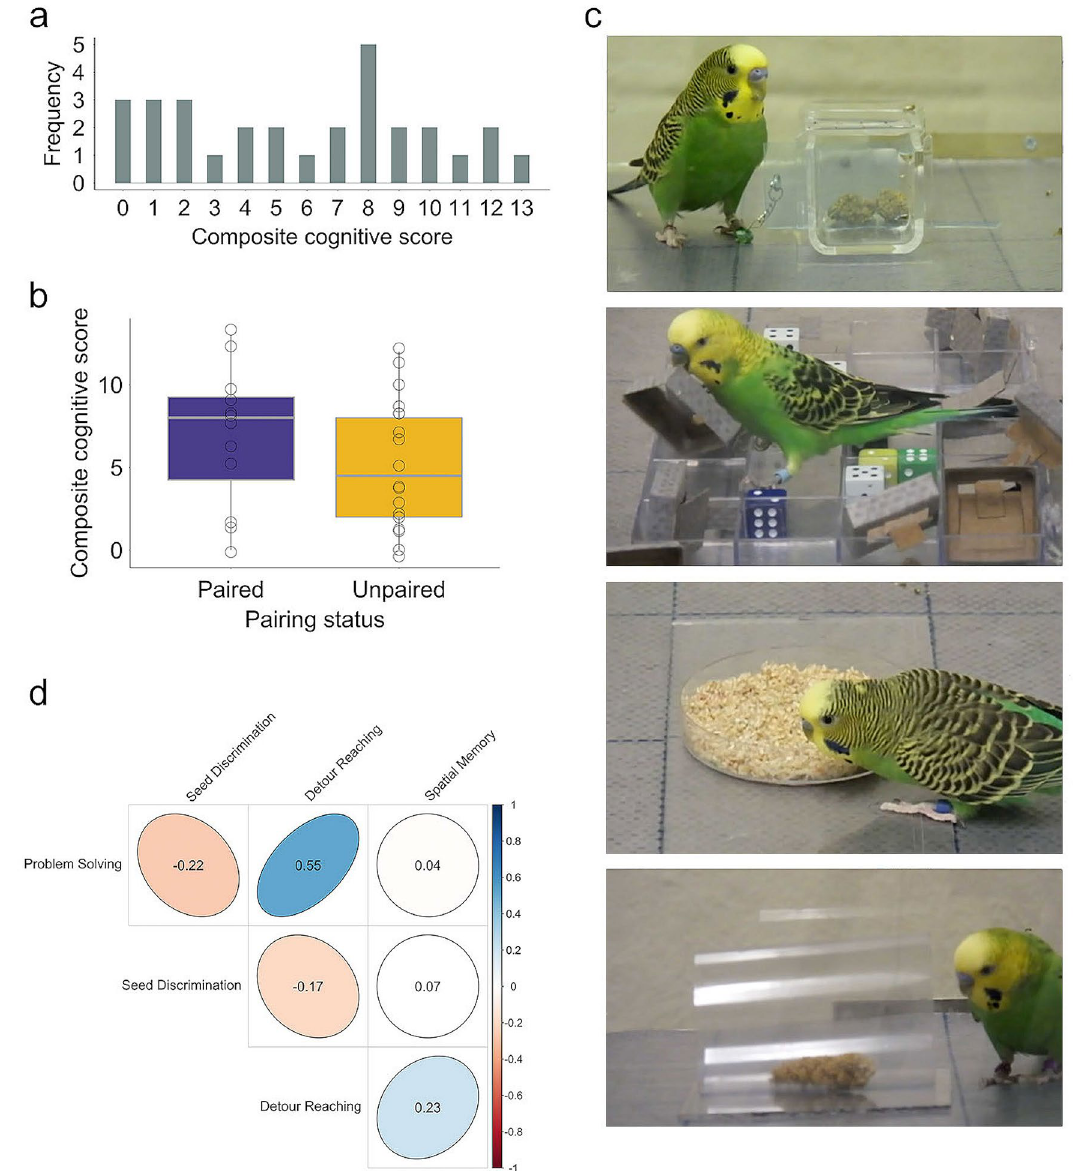
Figure 1. Females do not pair with social mates based on cognitive performance. ( a ) Distribution of the composite cognitive score of budgerigar males ( N = 30). ( b ) Composite cognitive scores did not differ between unpaired ( N = 18) and paired males ( N = 12) at the stage of choice for a social mate. Open circles represent each male, bars indicate the median across individuals in each group. ( c ) Devices employed to assess cognitive abilities in male budgerigars. Top to bottom: problem-solving task; setup for testing spatial memory (colored plastic served as landmarks); seed discrimination task (seed husks were glued to the petri dish); detour-reaching task. ( d ) Spearman rank correlations between performance in the 4 cognitive tasks. The cognitive measures compared were problem-solving score, maximum seed discrimination efficiency, detour-reaching score, and average number of errors in the spatial memory task. Blue indicates positive associations and red indicates negative associations. Numbers inside bubbles are the correlation coefficients. Number of pairwise comparisons ranged between 12 and 27. Correlations were not significant after the Bonferroni correction (α level of significance = 0.05/6 =